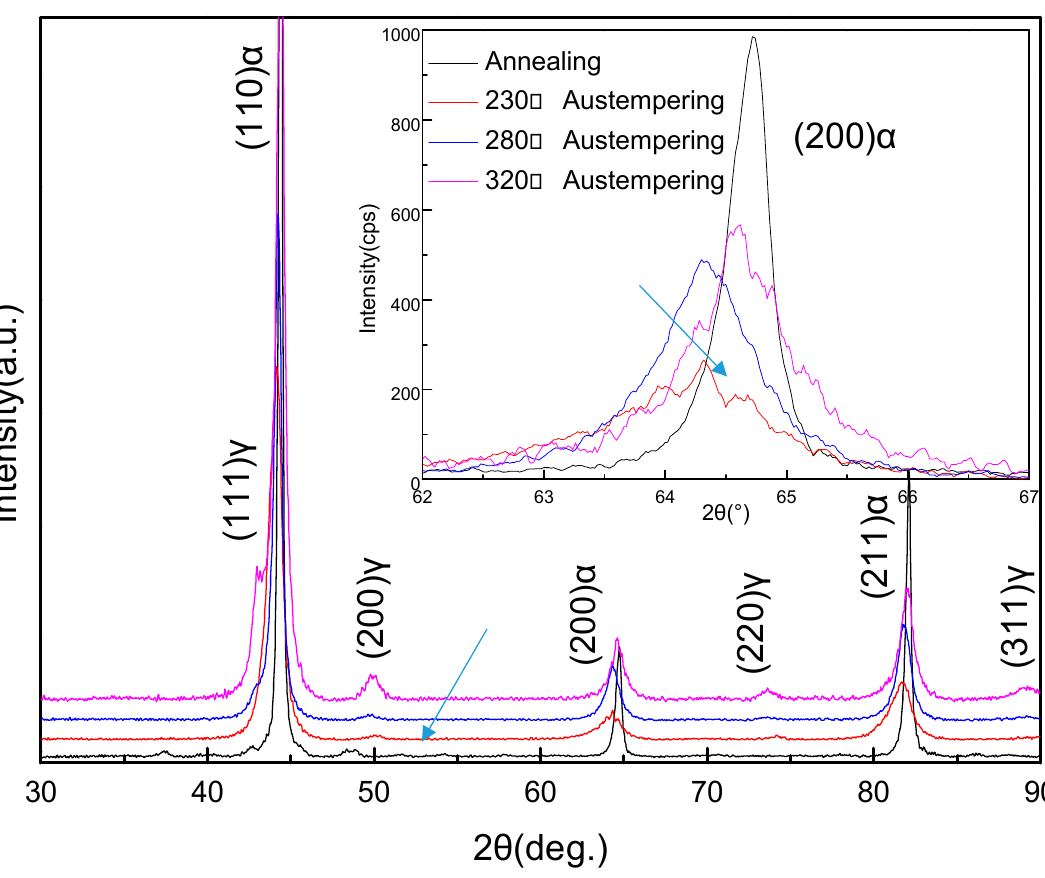
Figure 2. X-ray diffraction (XRD) patterns of the samples after heat treatment. α and γ denote the α -Fe lattice phase and the γ -Fe lattice phase, respectively. The figure at top right shows the XRD peaks from the (200) plane of the α -Fe lattice phase by slow scanning.